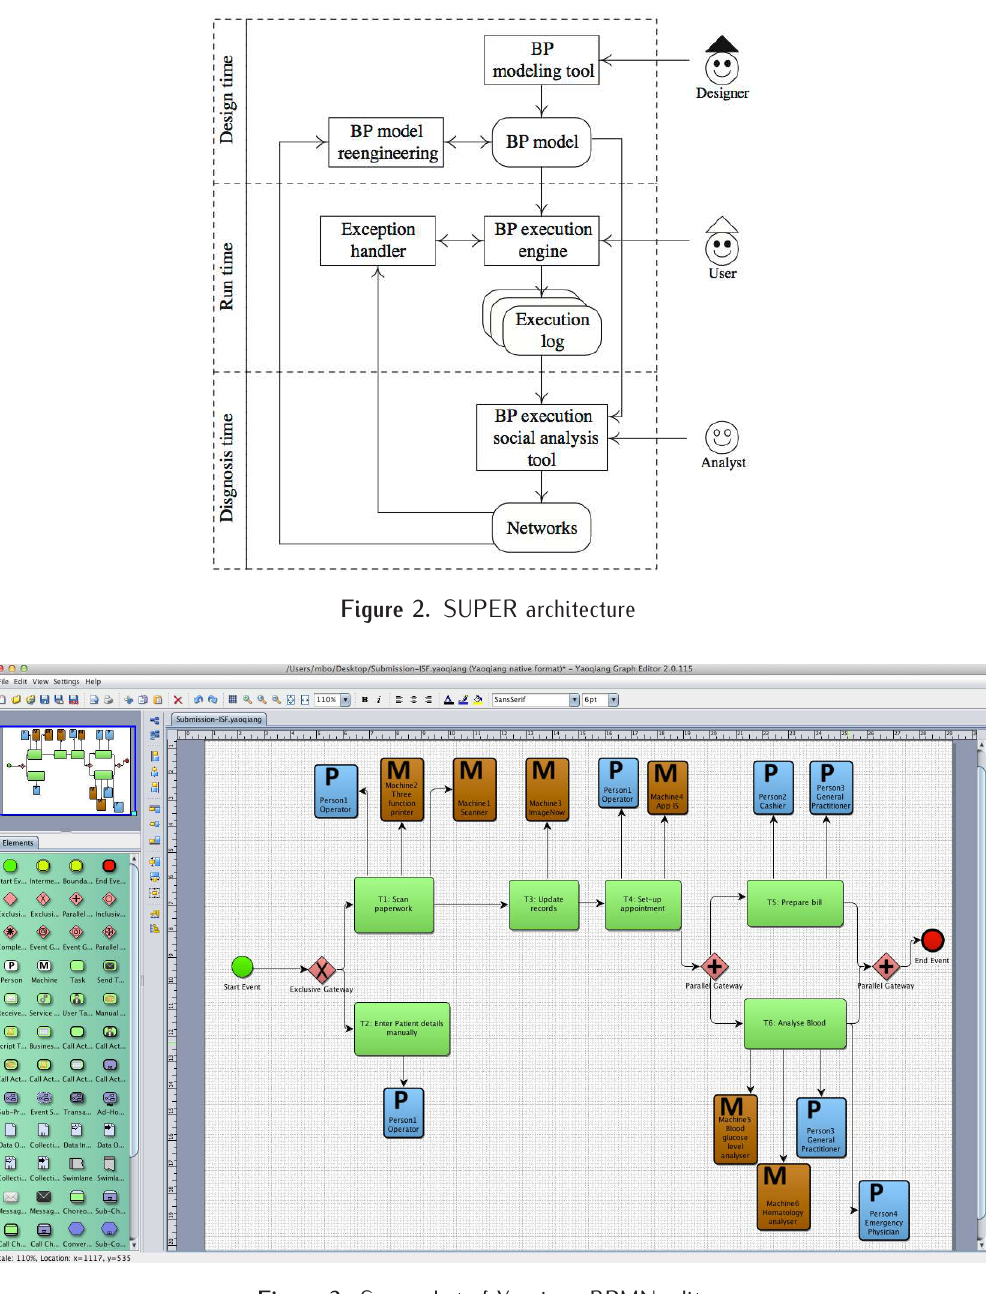
Figure 3. Screenshot of Yaoqiang BPMN